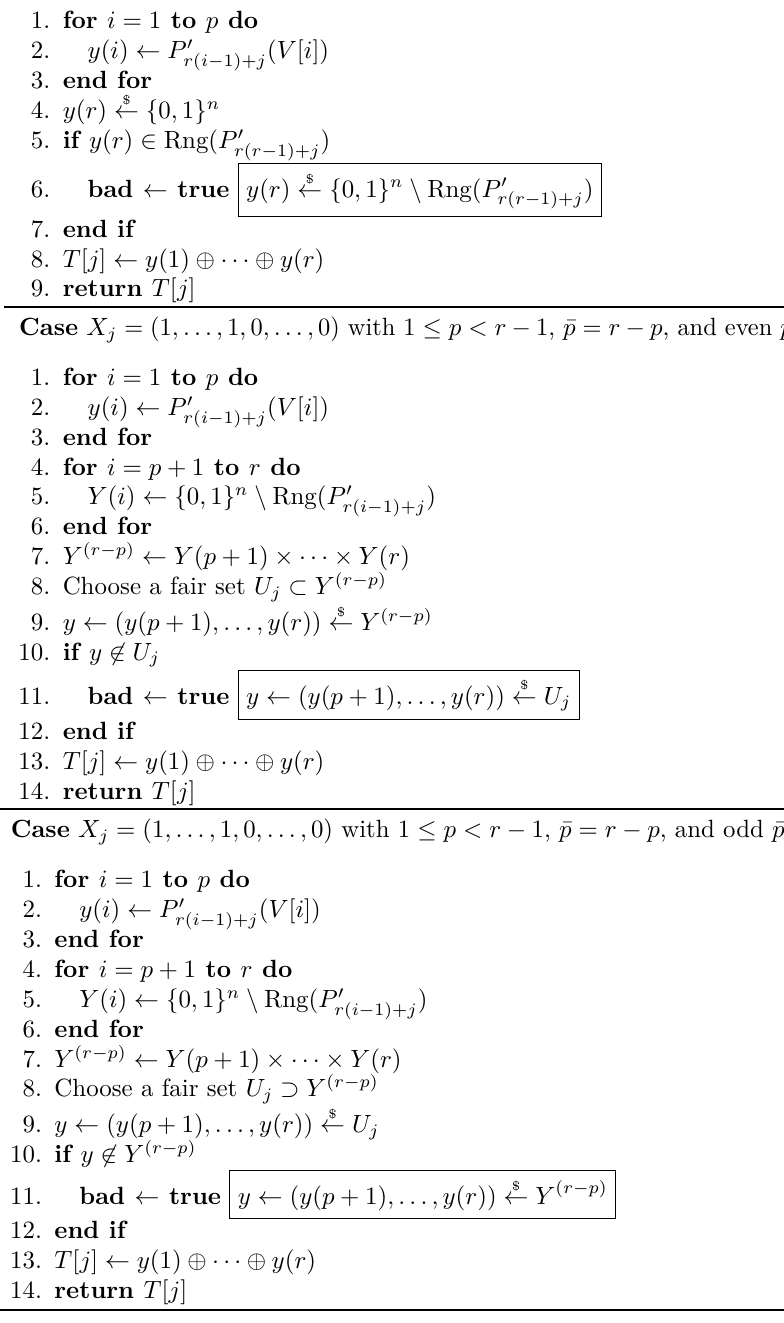
Figure 10: Case X j = (1 , . . . , 1 , 0 , . . . , 0) with wt ( X j ) = p and 1 ≤ p ≤ r − 1. When ¯ p = r − p is even, the boxed argument is only for the ideal game. When ¯ p is odd (including 1), the boxed arguments are only for the real